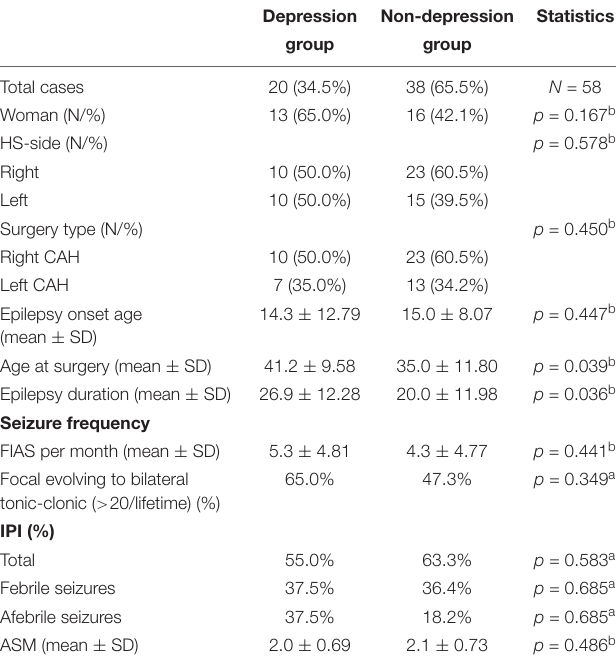
TABLE 1 | Clinical and neurological profile of this series of patients with mesial temporal lobe epilepsy and hippocampal sclerosis, with and without comorbid